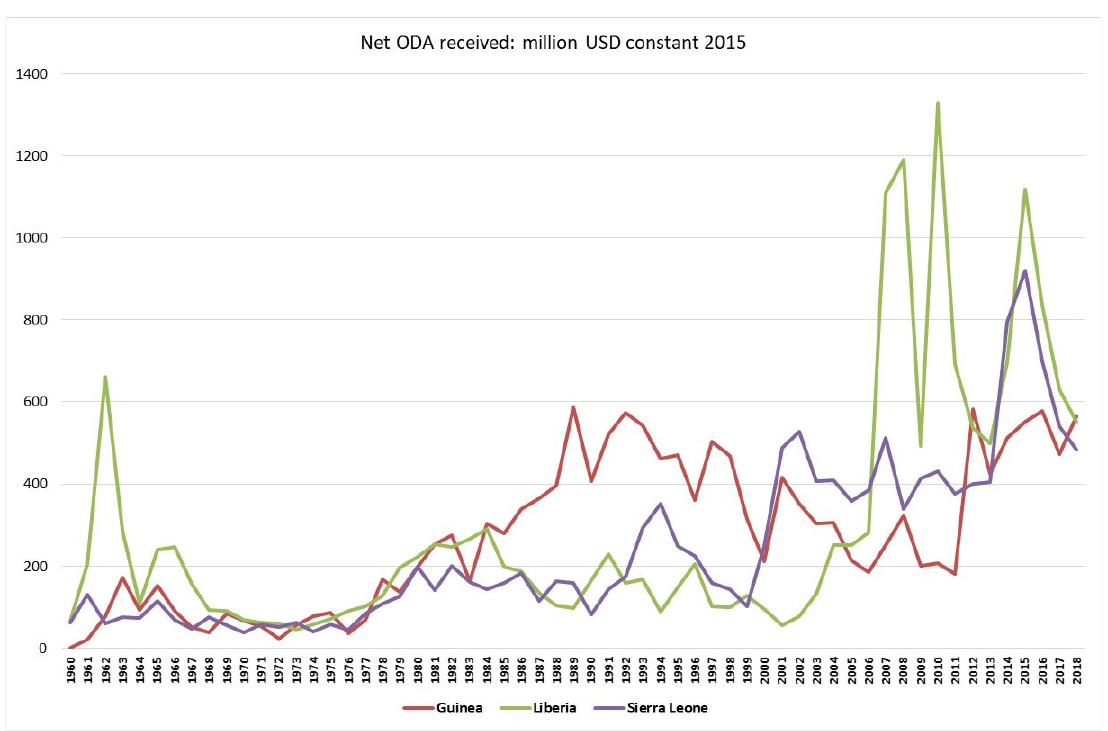
Figure 5. Time series of net ODA in constant dollars. Source: World Bank; World Development Indicators.